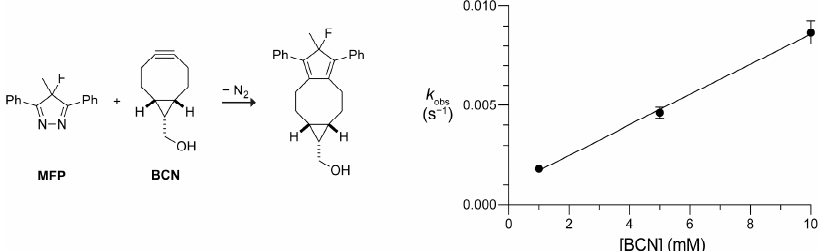
Figure 2. Reaction of endo -bicyclo[6.1.0]non-4-yn-9-ylmethanol (BCN) (1, 5, or 10 mM) with 4-fluoro-4-methyl-3,5-diphenyl-4 H -pyrazole (MFP) (0.1 mM) in 9:1 methanol/water. Values of k obs are the mean